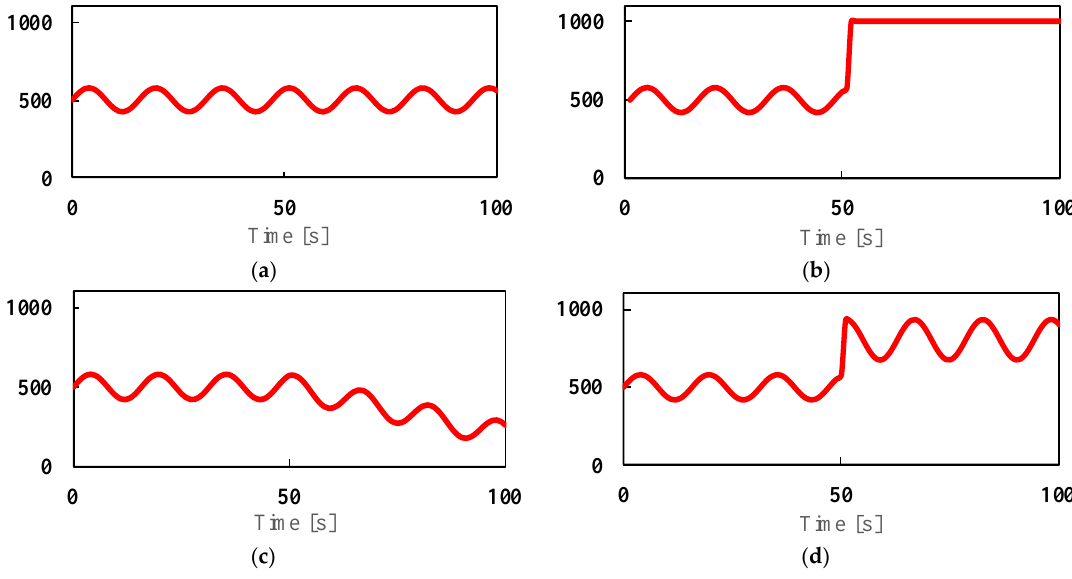
Figure 5. Schematic diagram of fault samples. ( a ) Normal data; ( b ) stuck fault; ( c ) drift fault; and ( d ) gain fault.